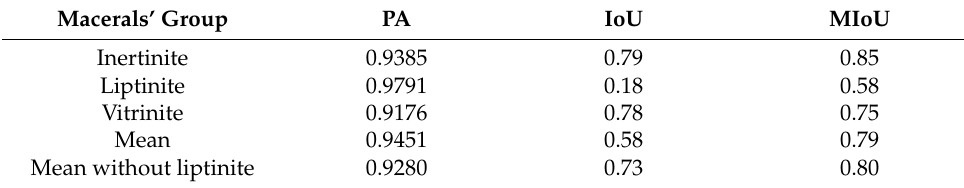
Table 3. The values of accuracy, IoU and MIoU obtained for validation images set.